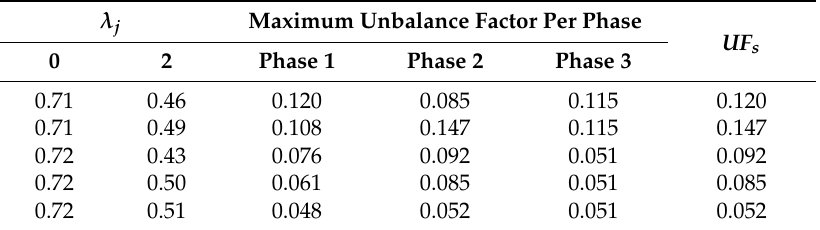
Table 2. Unbalance factors computed per phase for the example in Figure 3, with different λ values using the proposed method.